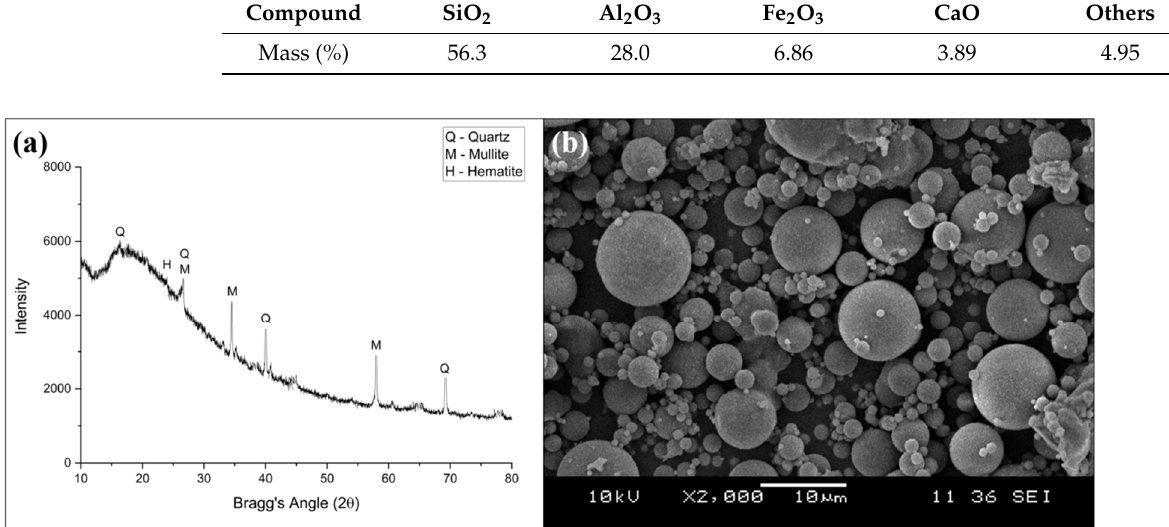
Table 1. Chemical composition of Class F fly ash determined using X-ray Fluorescence (XRF). Compound